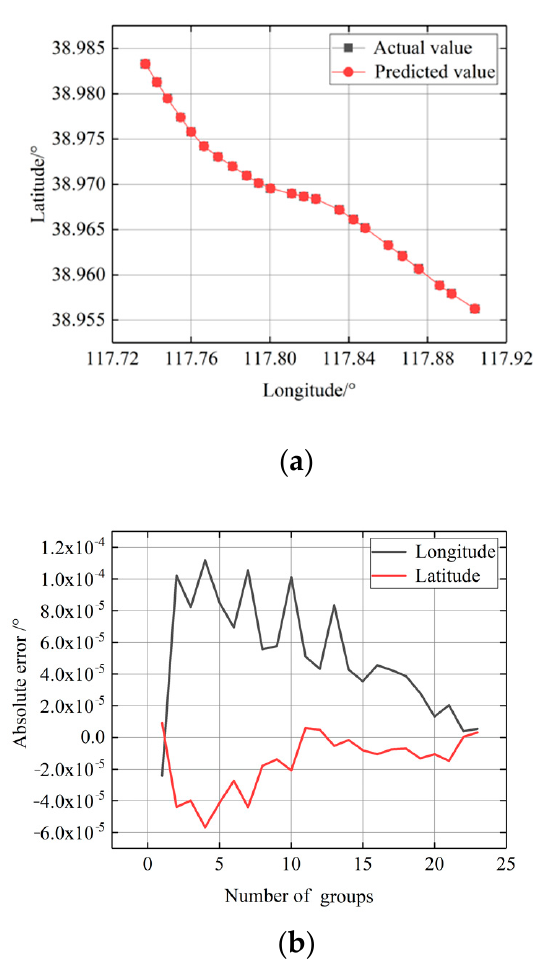
Figure 11. Prediction results of d-trajectory using the ACDE-SVR model. ( a ) Comparison of predicted and actual values of d-trajectory; ( b ) Longitude and latitude absolute error values of d-trajectory.